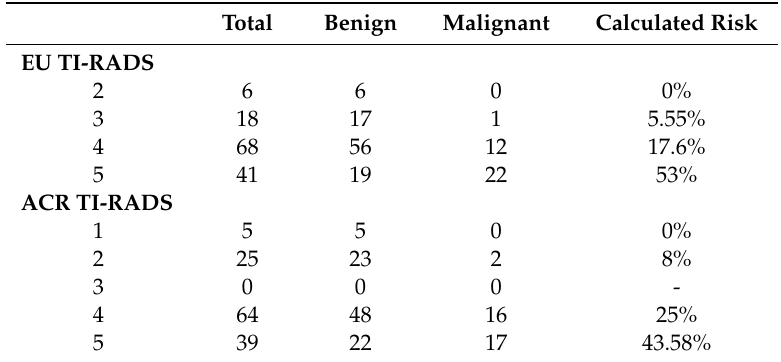
Table 5. Comparison of TI-RADS scores: Histopathological findings in the study group for each category and calculated malignancy risk for each